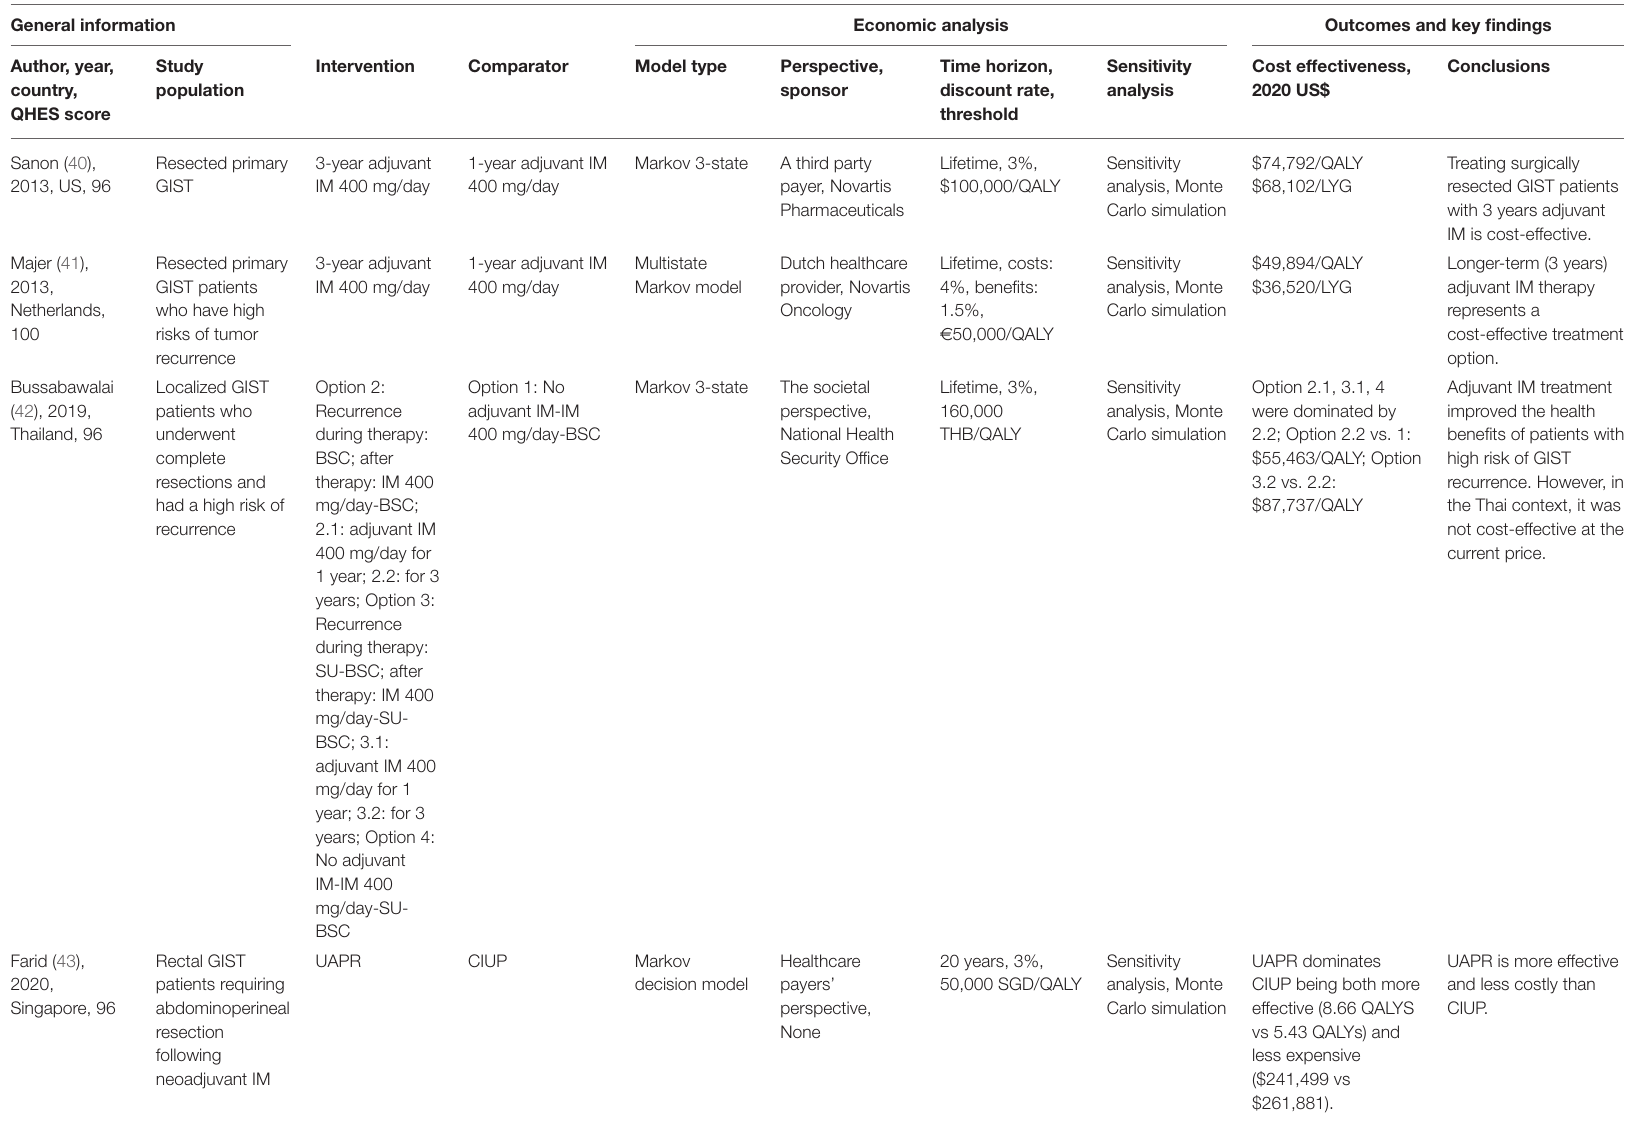
TABLE 2 | Summary of included economic evaluations for resectable